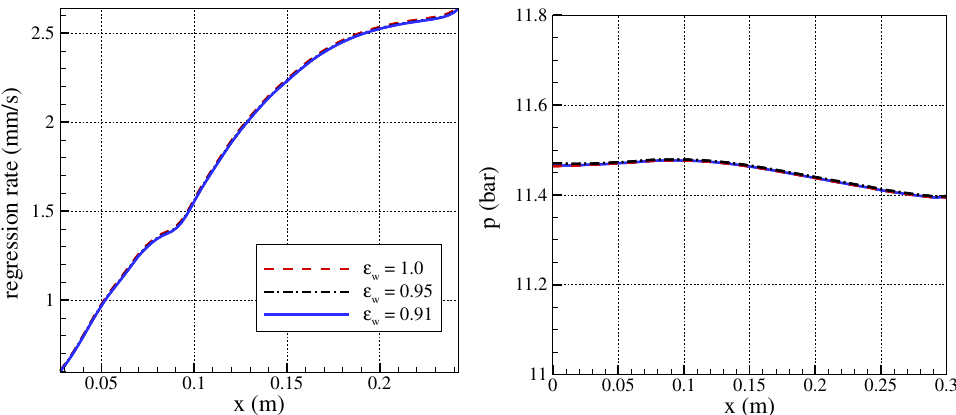
Figure 8. Effect of grain’s radiation emissivity on regression rate and pressure. As the turbulent Schmidt number is reduced, mixing is enhanced due to the increased turbulent diffusivity; hence, higher regression rate and pressure are obtained (Figure 9). Different turbulent Schmidt numbers entail 1–3% changes in average regression rates and chamber pressures; however, it is worth noting that typical values of turbulent Schmidt numbers used in the literature are in the range 0.7–0.9. On the other hand, regression rate and pressure are insensitive to changes in the laminar Schmidt number (Figure 10). In fact, molecular diffusion phenomena are not expected to play a significant role in this fuel-rich test case, as next to the wall, there is mostly paraffin. The small sensitivity of regression rate and pressure to the laminar and turbulent Schmidt numbers justifies the adoption of Fick’s law and the assumption of constant Schmidt numbers in this work and allows us to avoid using other multicomponent diffusion models.